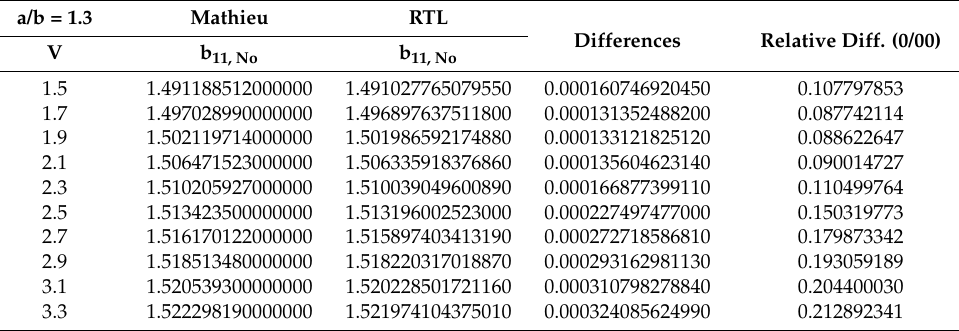
Table 2. Comparison of ellipse for the fundamental